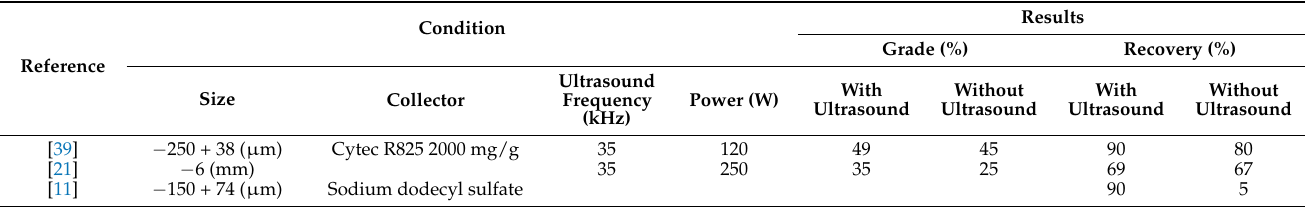
Table 1. Influence of ultrasonic waves on the flotation of borax